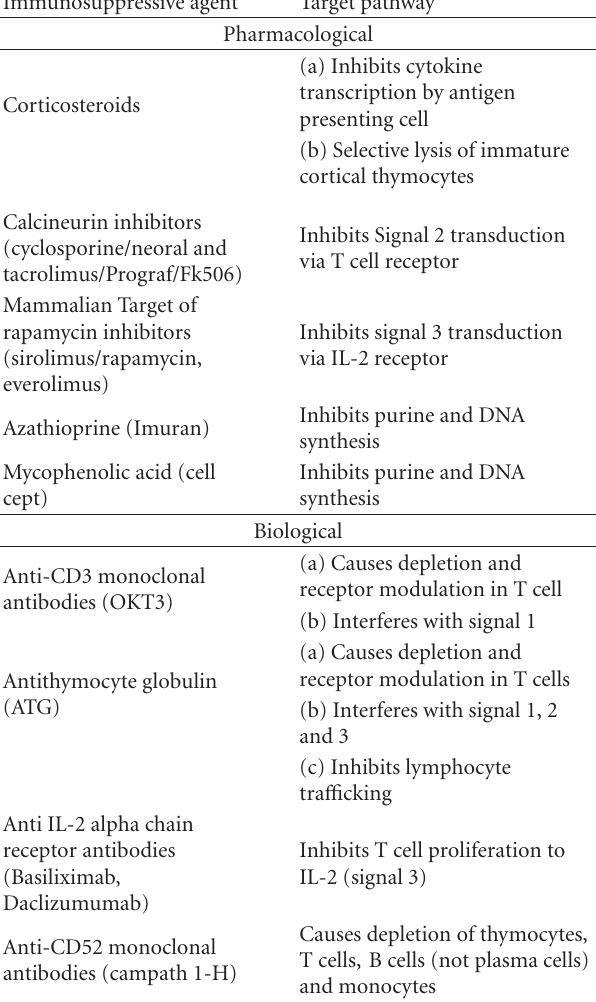
Table 1: Commonly used immunosuppressive agents in liver transplantation and their target